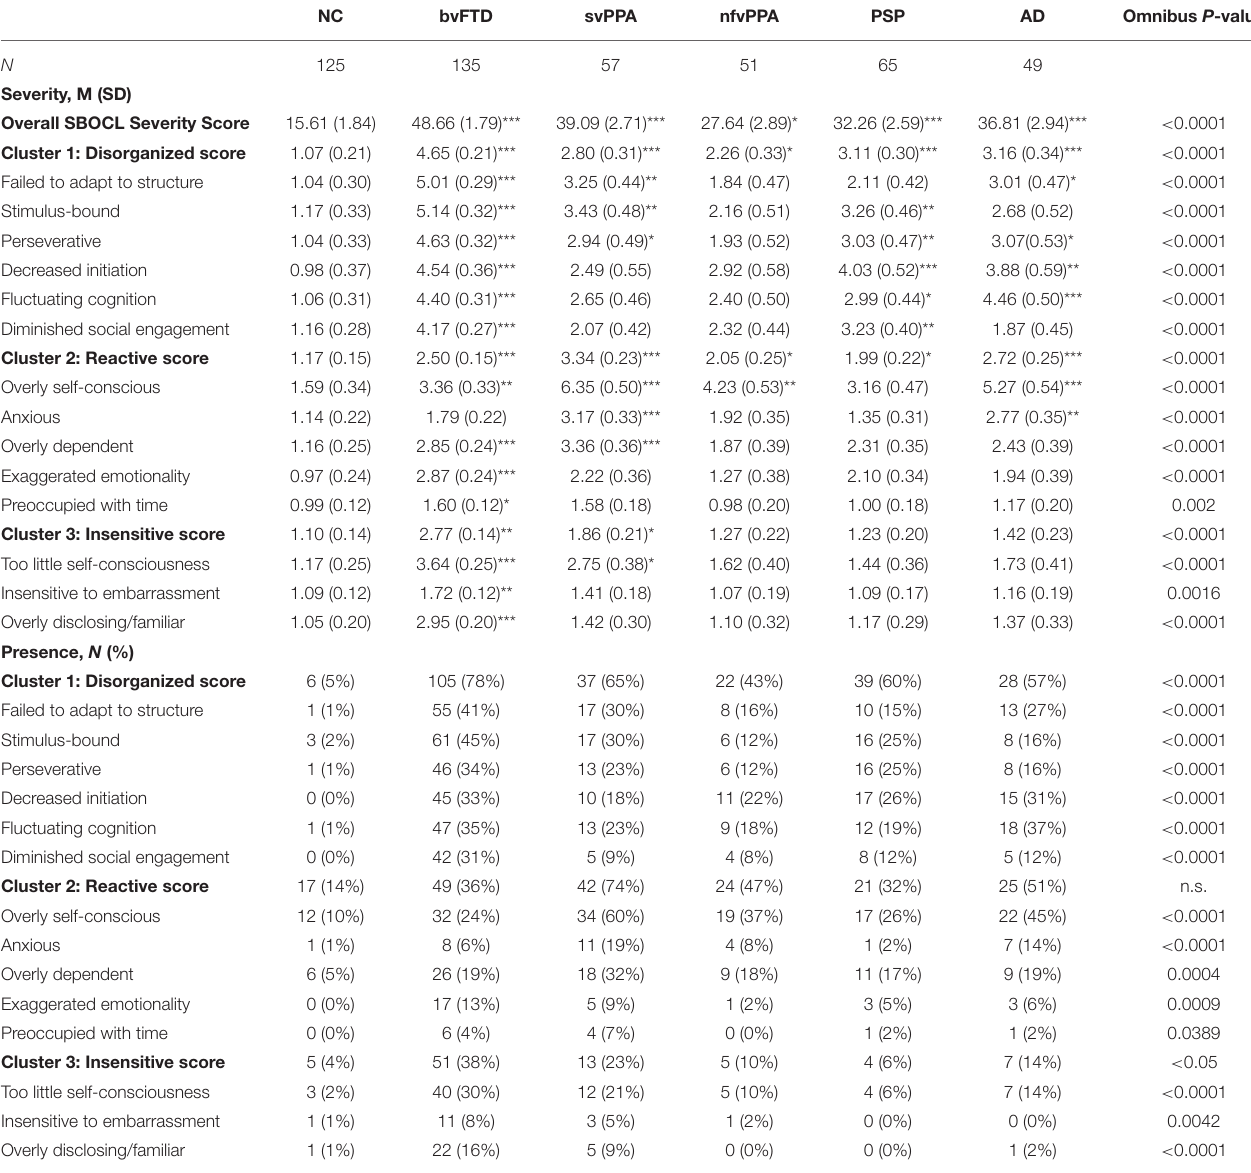
TABLE 2 | Overall, cluster, and item presence and severity scores for each diagnostic